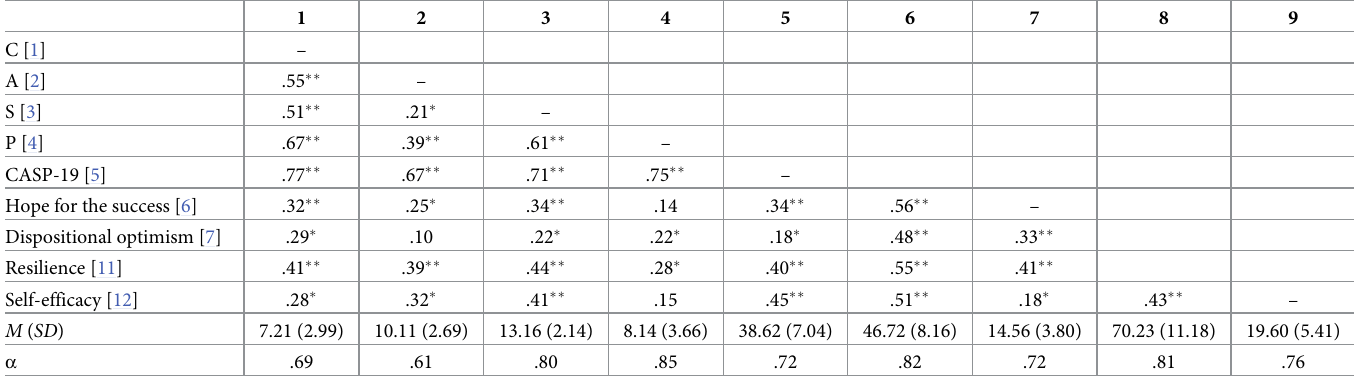
Table 2. Descriptive statistics and correlations between the analyzed variables (N =